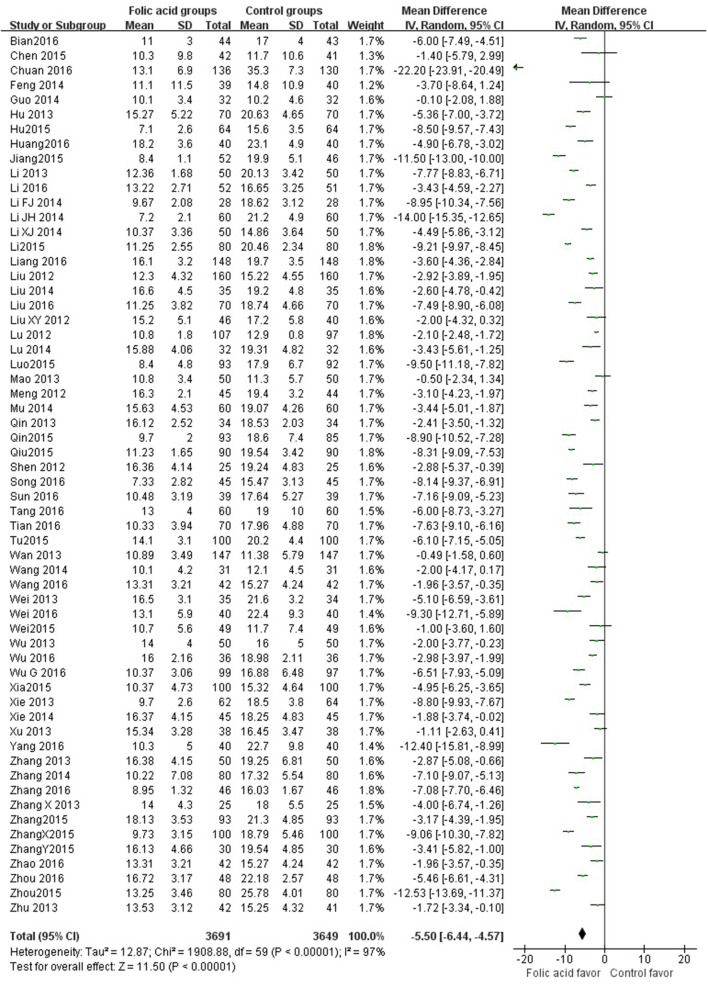
Forest Plot of effect sizes for tHcy level.